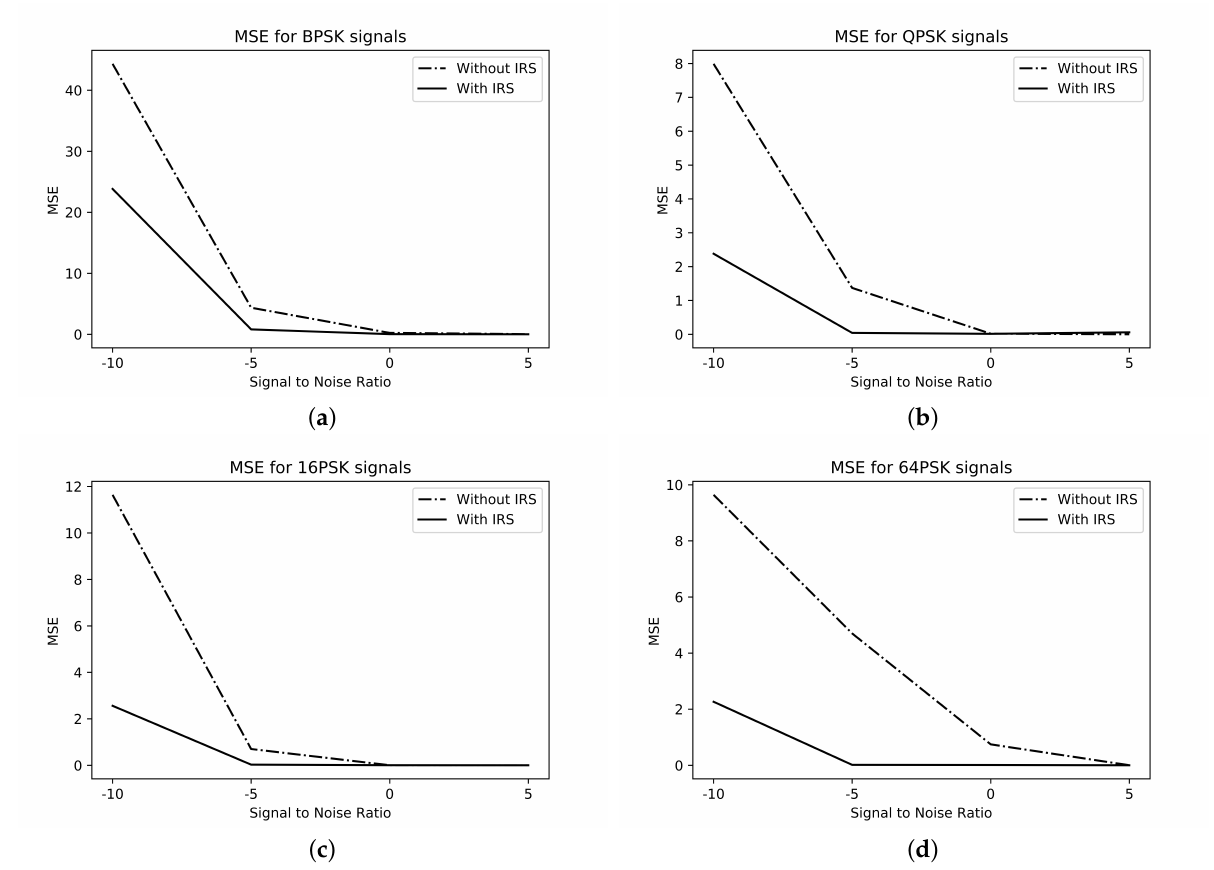
Figure 3. MSE for M-PSK signals. ( a ) BPSK; ( b ) QPSK; ( c ) 16-PSK; ( d ) 64-PSK.